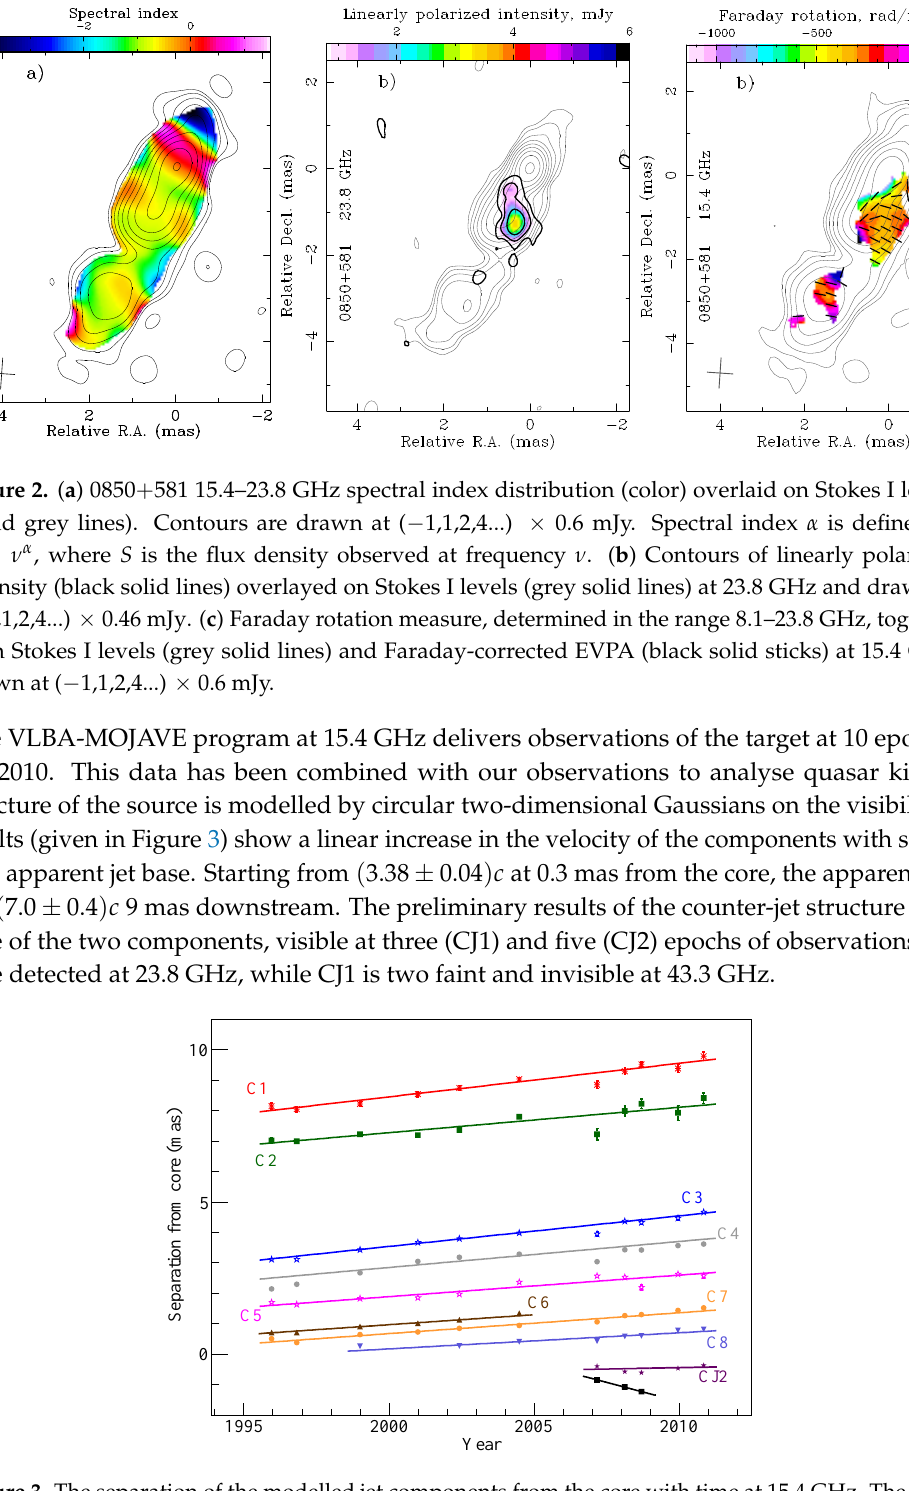
Figure 3. The separation of the modelled jet components from the core with time at 15.4 GHz. The solid lines represent a linear fit to the data points. The nomenclature for jet components has been adapted from [14] and is shown by